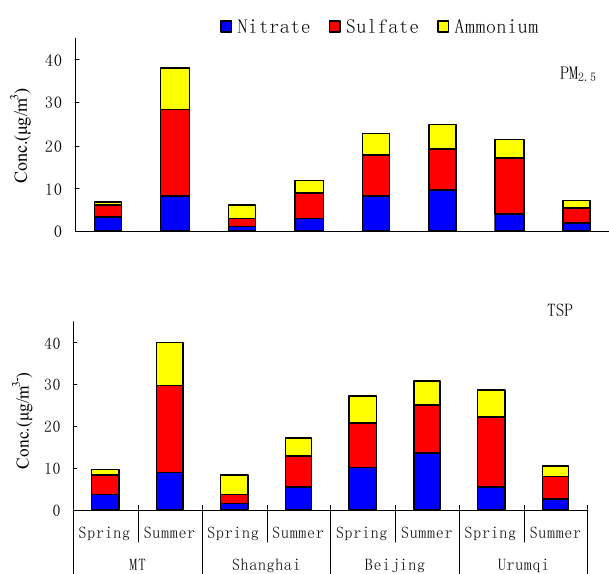
Fig. 9. Seasonal variations of SO 42- , NO 3- , and NH 4+ in aerosols at different sampling sites.